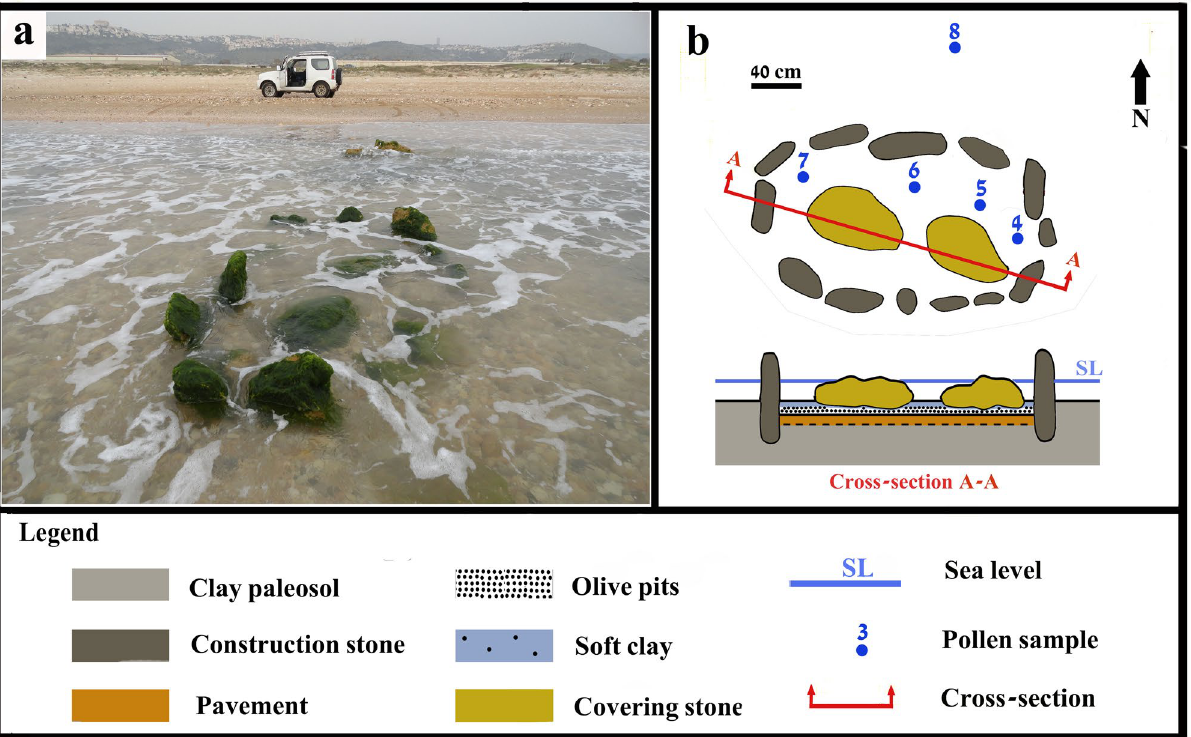
Figure 3. ( a ) Structure A as uncovered during 2011; ( b ) Plan and cross-section of Structure A (SL refers to the lowest tide during the drawing of the structure on the 2.2.2018 at 5 PM) (Photos and drawing Ehud